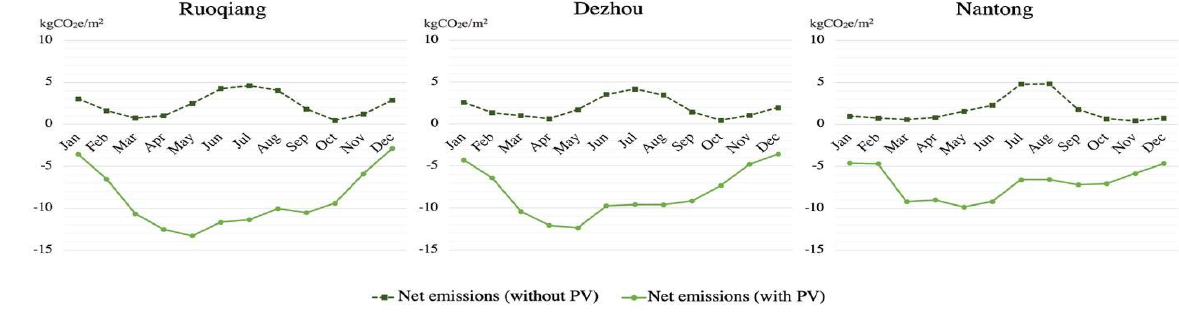
Figure 6 Monthly net carbon emissions during the operation phase.